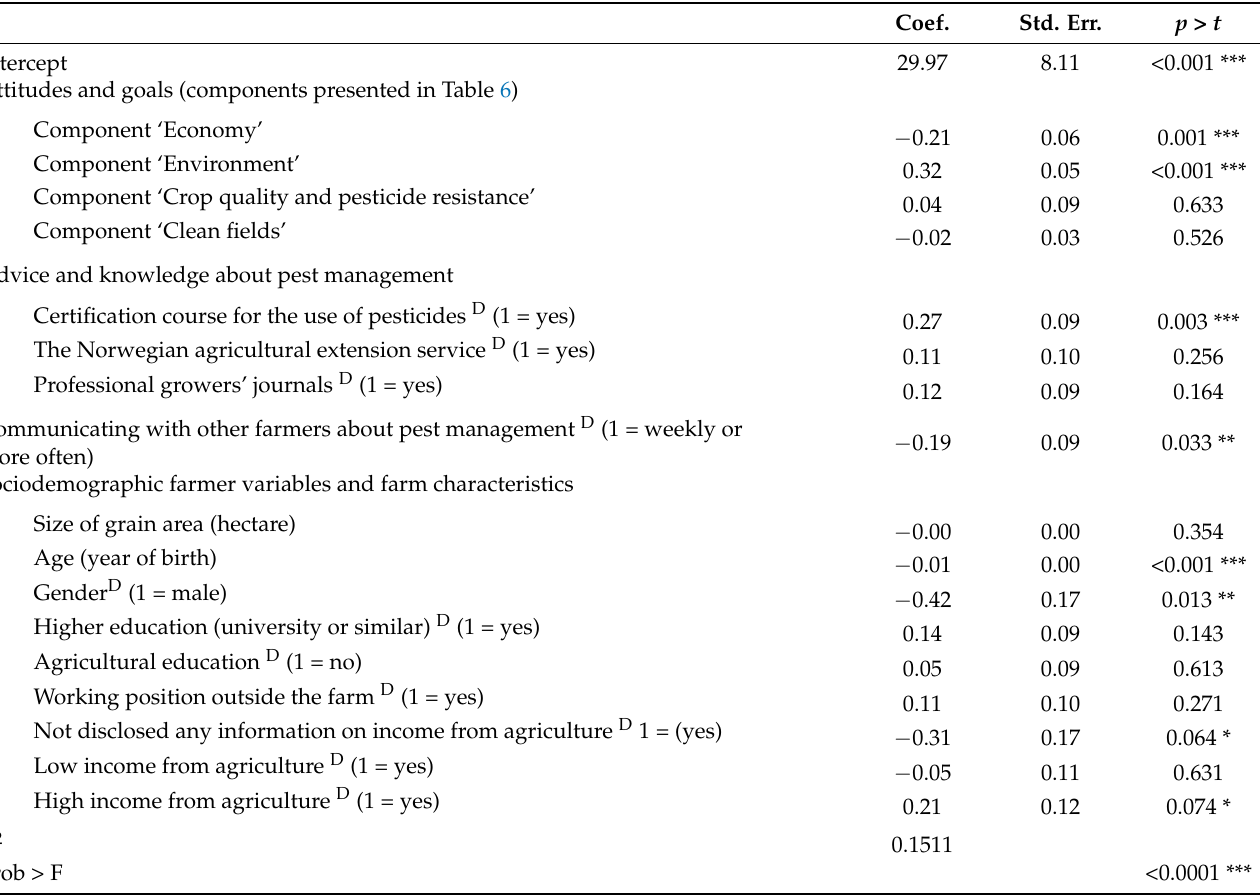
Table 7. Regression model for response to the item “I am positive about IPM even though it can entail reduced profits” 1 (Post-survey, N = 616). Prob > F <